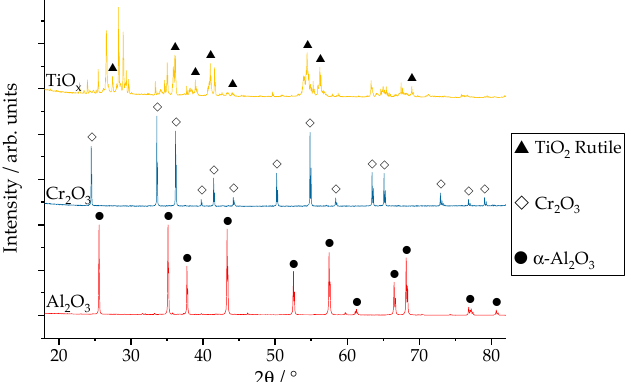
Figure 2. XRD pattern of the feedstock powders.